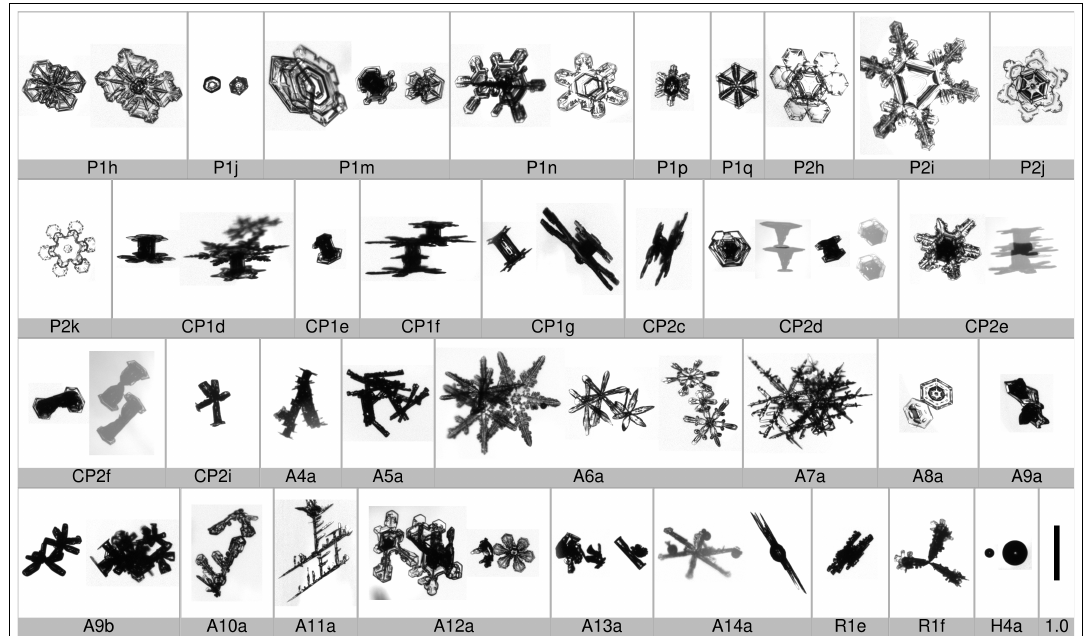
Figure 2. The 34 new shapes found in Kiruna: Table 2 shows their completed name. The same scaling is applied to all images; a 1.0-mm scale bar is shown as reference. In some cases, more images of the same shape are shown to indicate possible differences found in the same shape. In other cases, side- and top-view images of the particle shape are shown for better shape